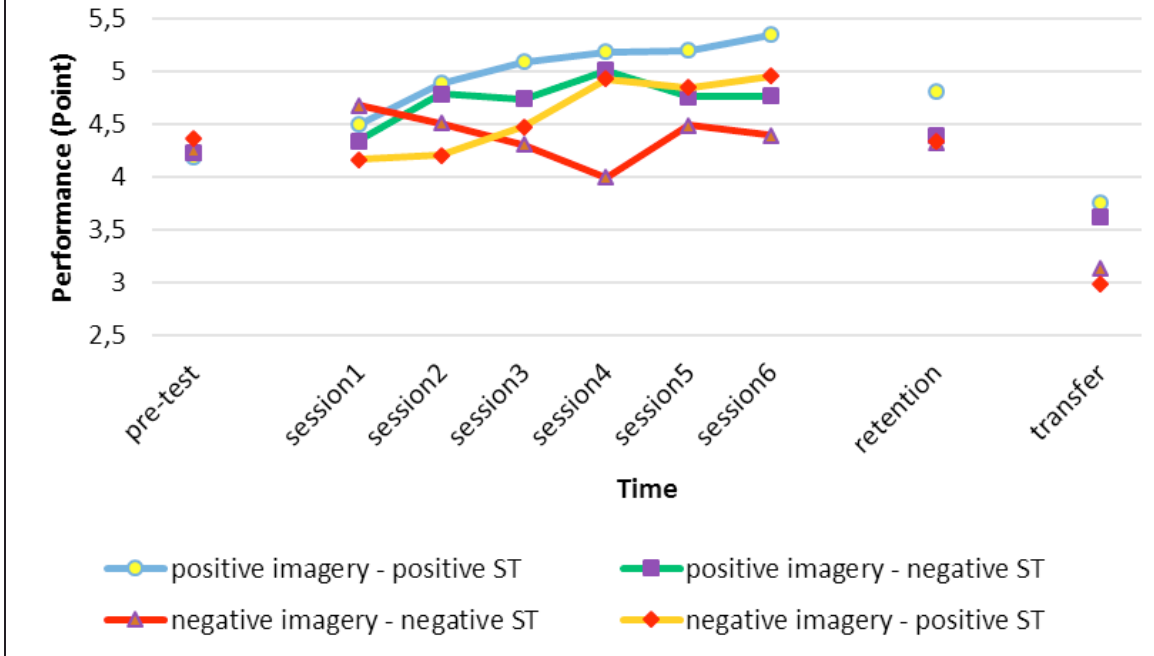
Figure 1. Mean of performance in different